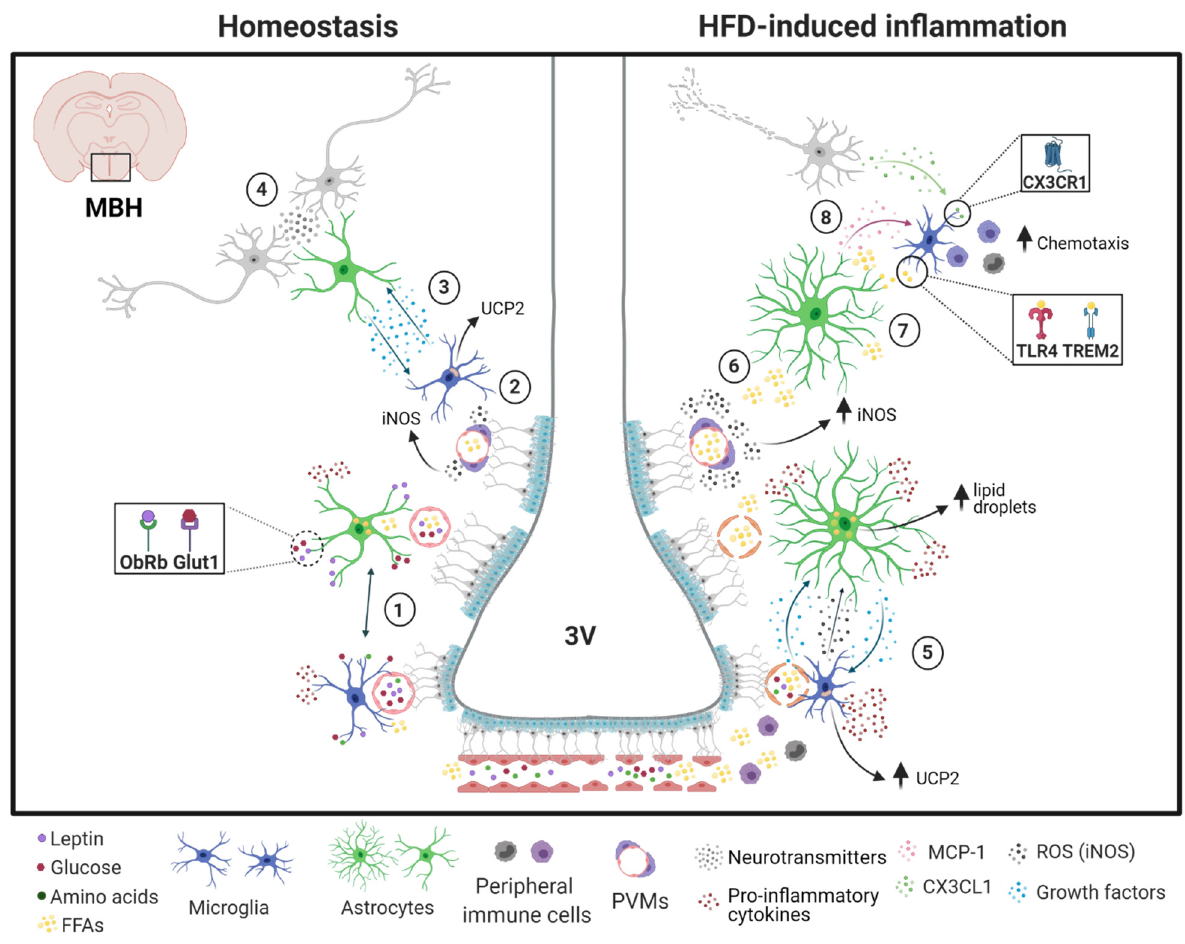
Figure 2. Microglia and astrocyte crosstalk in the hypothalamus. In homeostatic conditions: ( 1 ) microglia and astrocytes sense nutrients (amino acids, glucose, and free fatty acids [FFAs], among others) and hormones (e.g., leptin) that enter the hypothalamic parenchyma and react to those environmental changes. Astrocytes regulate lipid metabolism and storage and trigger metabolic changes due to hormone binding to their surface receptors (e.g., leptin and glucose receptors). ( 2 ) UCP2 expression in microglia is tightly controlled preserving their mitochondrial function while PVMs release normal levels of iNOS in response to FFAs concentration in blood vessels. ( 3 ) Microglia and astrocytes interact via contact-dependent and secreted factors and ( 4 ) control synapse development and function. Under high-fat feeding: ( 5 ) Glial cells quickly sense environmental changes and become reactive, releasing several pro-inflammatory cytokines and growth factors (e.g., VEGF and TGF- β 1), and increasing reactive oxygen species (ROS) production. Astrocytes store the excessive FFAs in lipid droplets while microglial UCP2 increases, promoting astrogliosis and mitochondrial dysfunction in microglia. ( 6 ) PVMs surrounding blood vessels increase the release of iNOS promoting leaking BBB and facilitating the entrance of FFAs into the hypothalamic parenchyma, ( 7 ) which can stimulate IKK β /NF- κ B signaling by activating TLR4 and TREM2 in microglial cells. ( 8 ) Glial cells and neurons increase the synthesis of chemokines (e.g., MCP-1 and fractalkine), leading to the recruitment of peripheral myeloid cells to the central nervous system. If the inflammatory stimulus persists, the astrocytic control of synaptic functions become impaired, resulting in neuronal dysfunction. Abbreviations: 3V, third ventricle; MBH, mediobasal